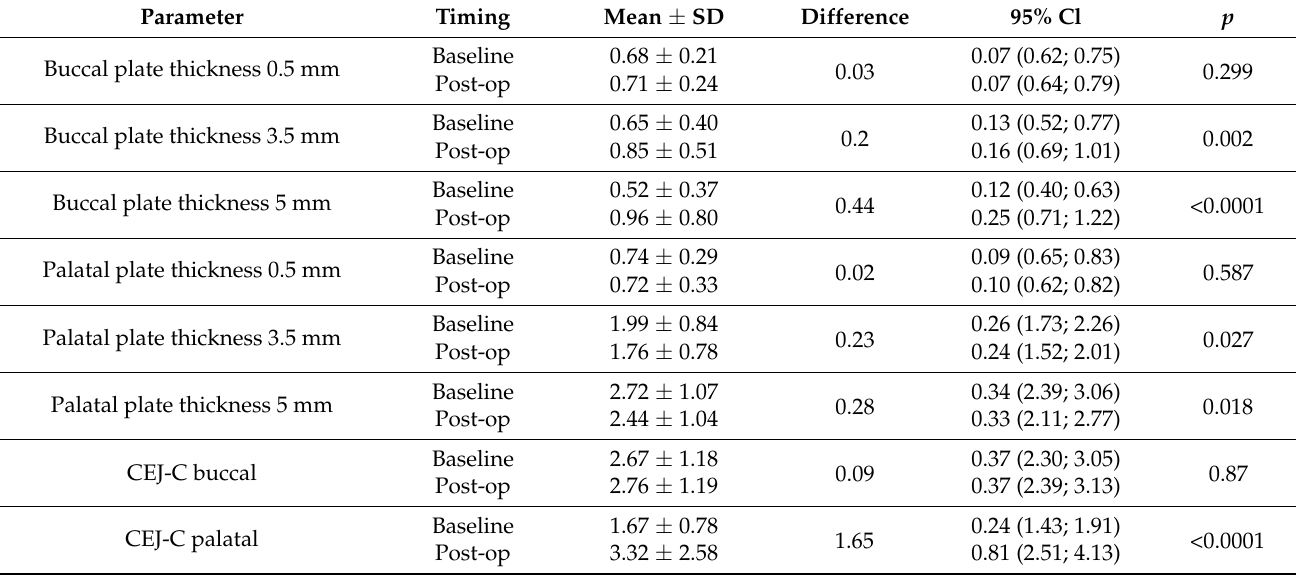
Table 3. Distribution of CBCT parameters for incisors before and after orthodontic treatment.